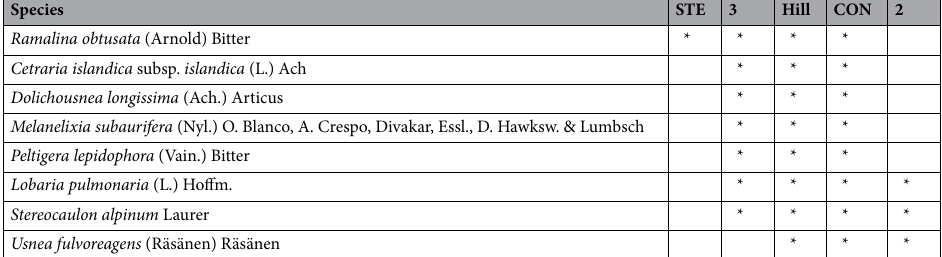
Species STE 3 Hill CON 2 Ramalina obtusata (Arnold) Bitter Cetraria islandica subsp. islandica (L.) Ach